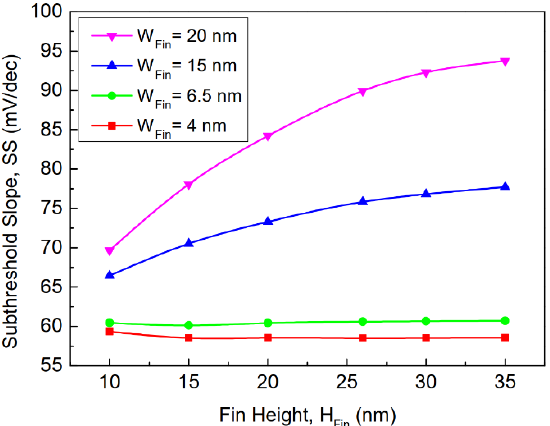
Figure 8. Behavior of the subthreshold slope as a function of fin height for FinFET devices with different values of the fin width at V ds = 0.05 V.